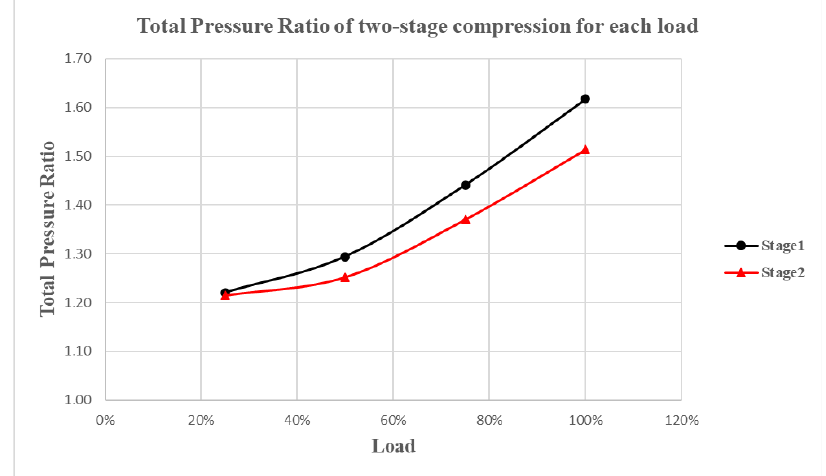
Figure 9. Comparison diagram of pressure ratios of R-513A refrigerant two-stage compression under various loads.